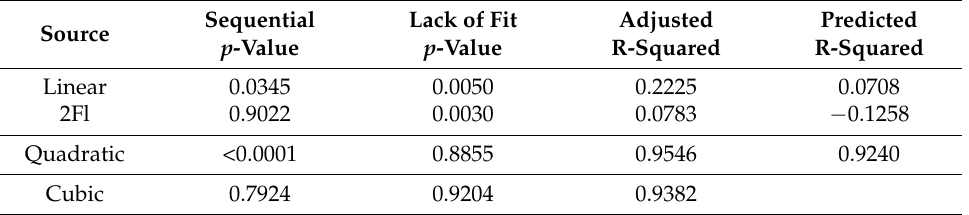
Table 6. Different statistical values form Model Fit Summary